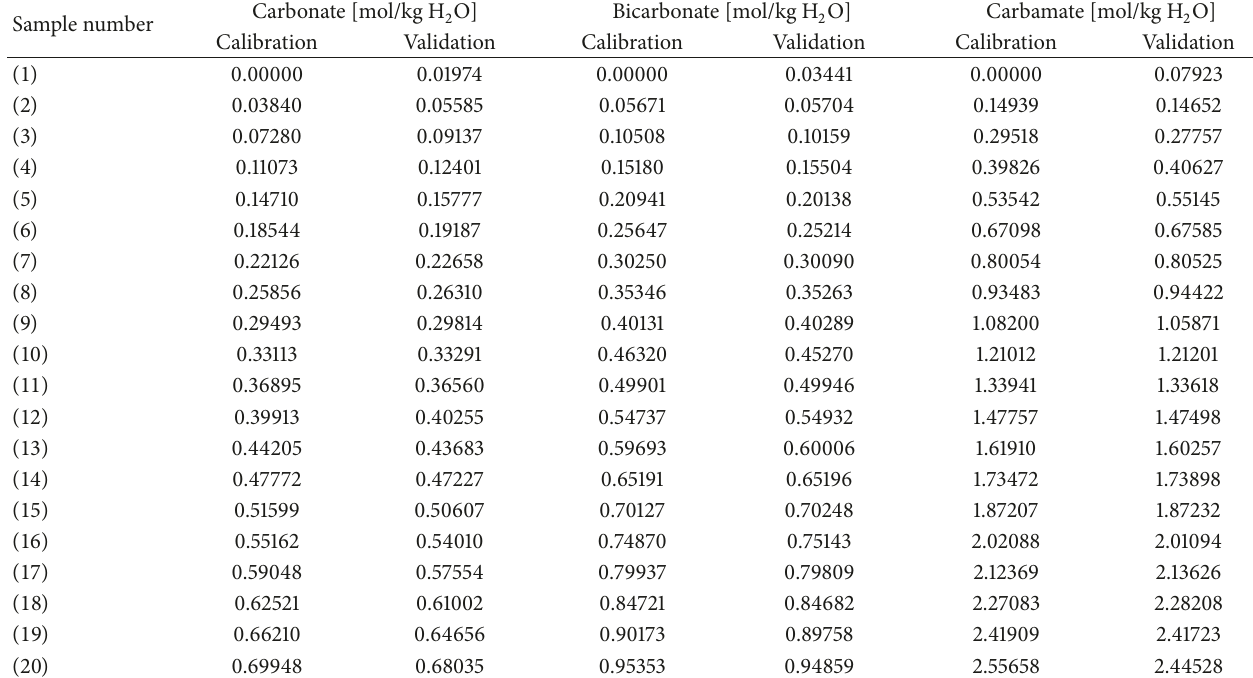
Table 4: Overview of sample solutions reported as mol/kg H 2